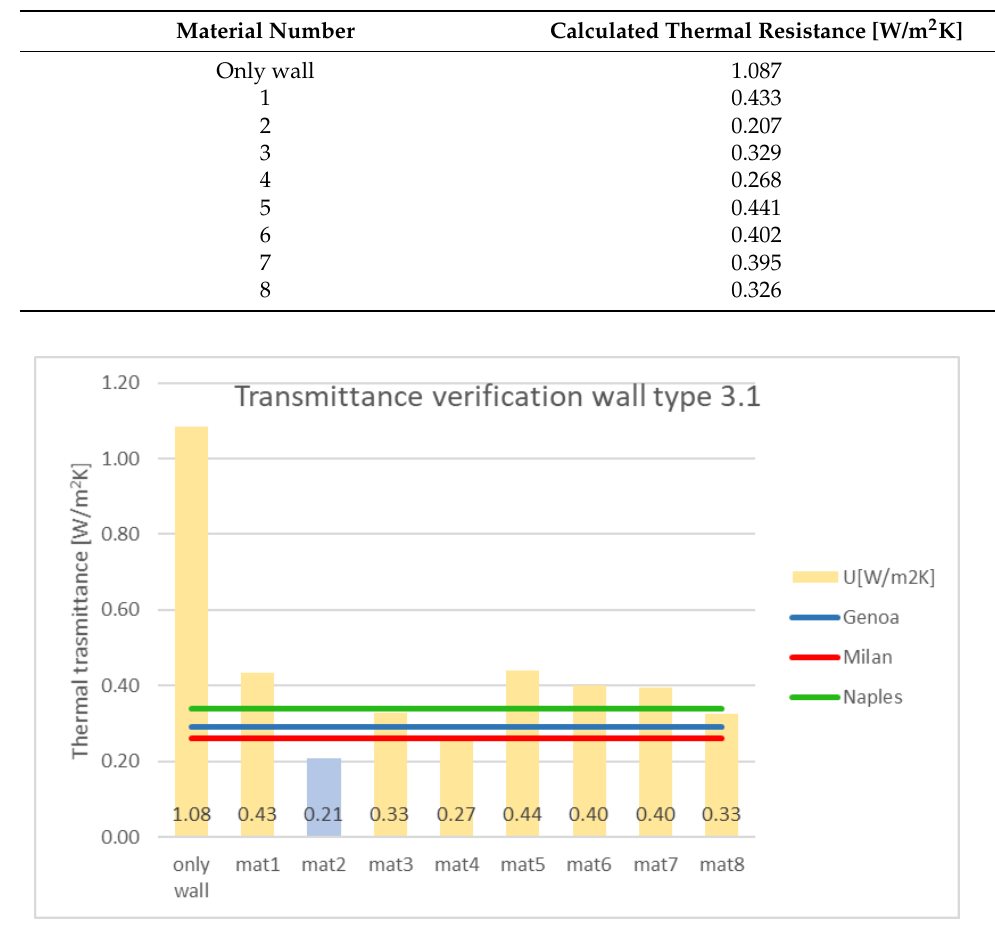
Figure A6. Wall type 3.1: transmittance check for the three main Italian climatic zones. In blue are the heat-reflective materials which respect all the limits.